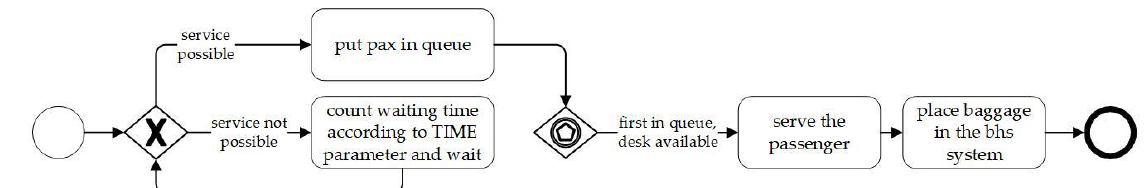
Figure 4. Passenger handling algorithm. Table 2. Probability density function of passenger service time depending on the TYPE parameter.